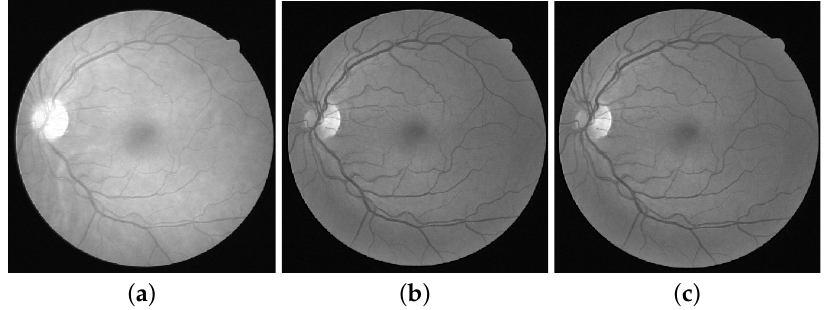
Figure 2. Retinal Image Conversion ( a ) Red ( b ) Green and ( c ) Blue, channels images.